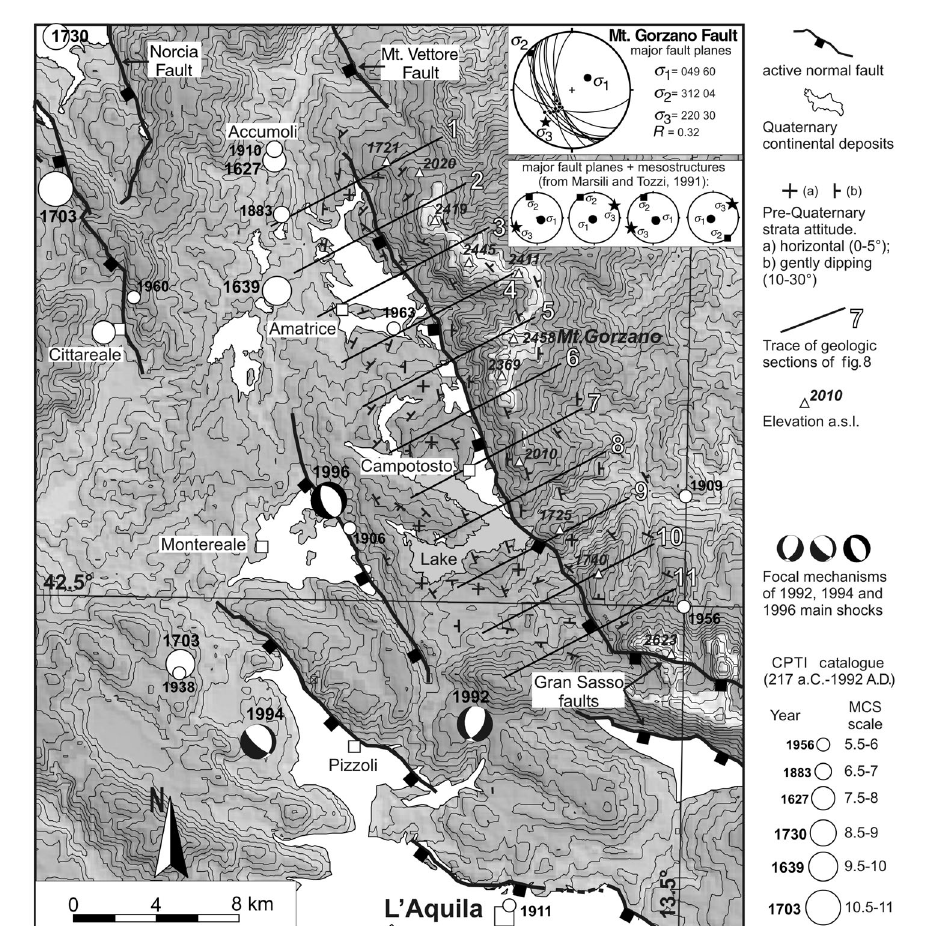
Fig. 7. Structural sketch and topography (contour interval is 100 m) of the Amatrice-Campotosto area. Inset at the top right corner: geometry and kinematics of the Mt. Gorzano active normal fault and stress parameters ob- tained in this work by inversion of major fault planes; the stress axes obtained by inversion of both major and mesostructures (from Marsili and Tozzi, 1991) are also